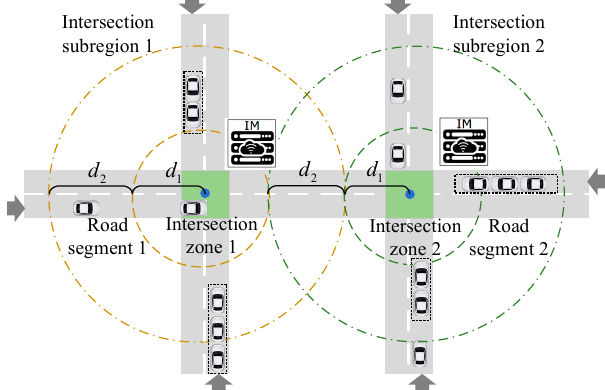
Figure 2. Studied scenarios of two intersections.